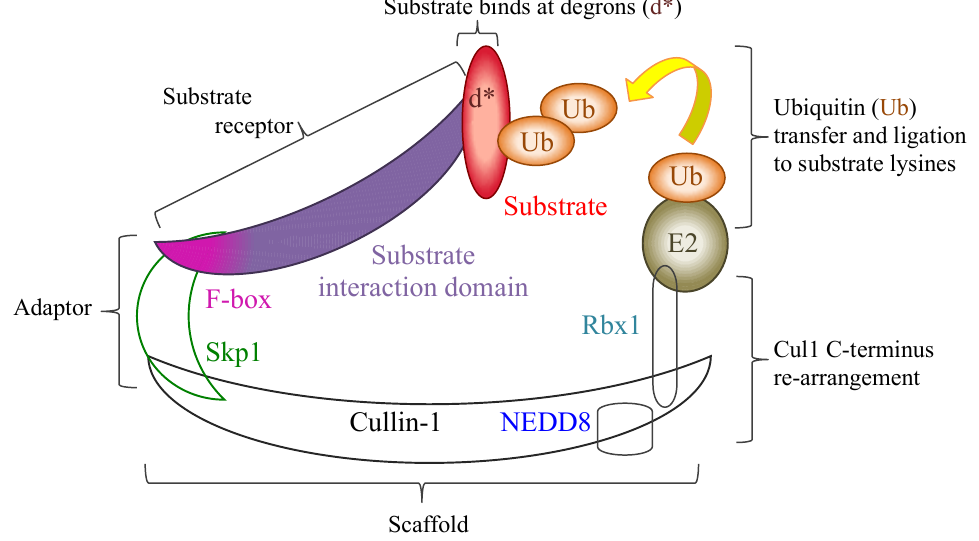
Figure 3. Representation of a cellular SCF1 ubiquitin ligase complex following